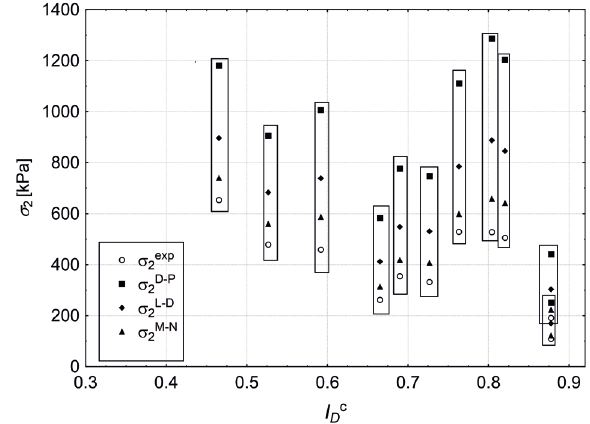
(Tables 3 and 4) 2